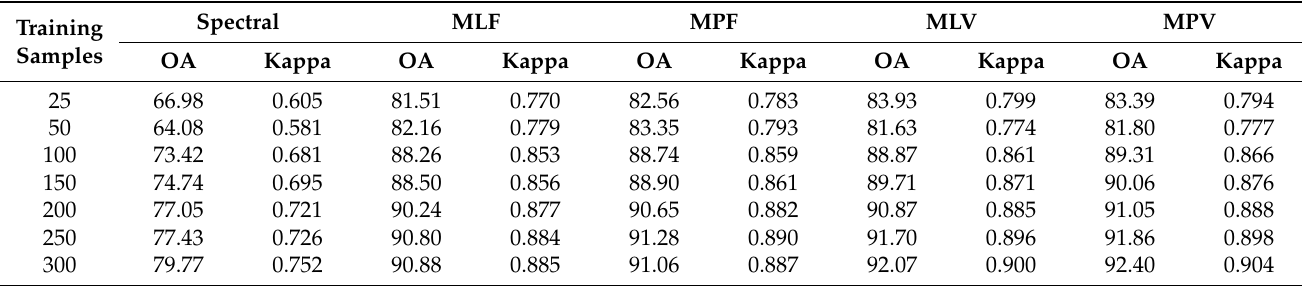
Table 6. OAs (%) and Kappa coefficients obtained by different methods for the Honghu dataset using SVM with different numbers of training samples per class.